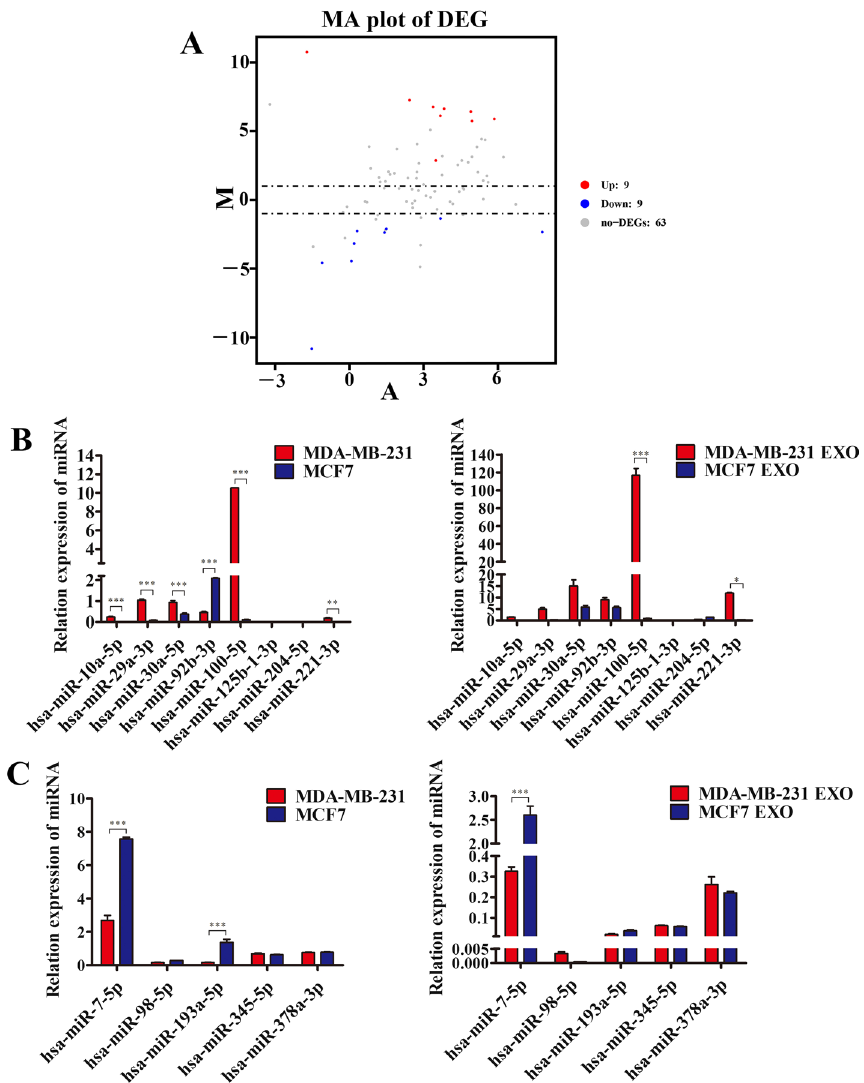
Fig. 2 Bioinformatic analysis to screen for differentially expressed miRNAs. A Bioinformatic analysis of the volcano plot results showed that MDA-MB-231 and MCF7 source differentially expressed miRNAs in exosomes. B The expression of selected eight up-regulated miRNAs in exosomes and cells was examined using real-time quantitative PCR. C Real-time quantitative PCR was used to detect the expression of selected five down-regulated miRNAs in exosomes and cells, respectively. Data are presented as mean * p < 0.05, ** p < 0.01, *** p <